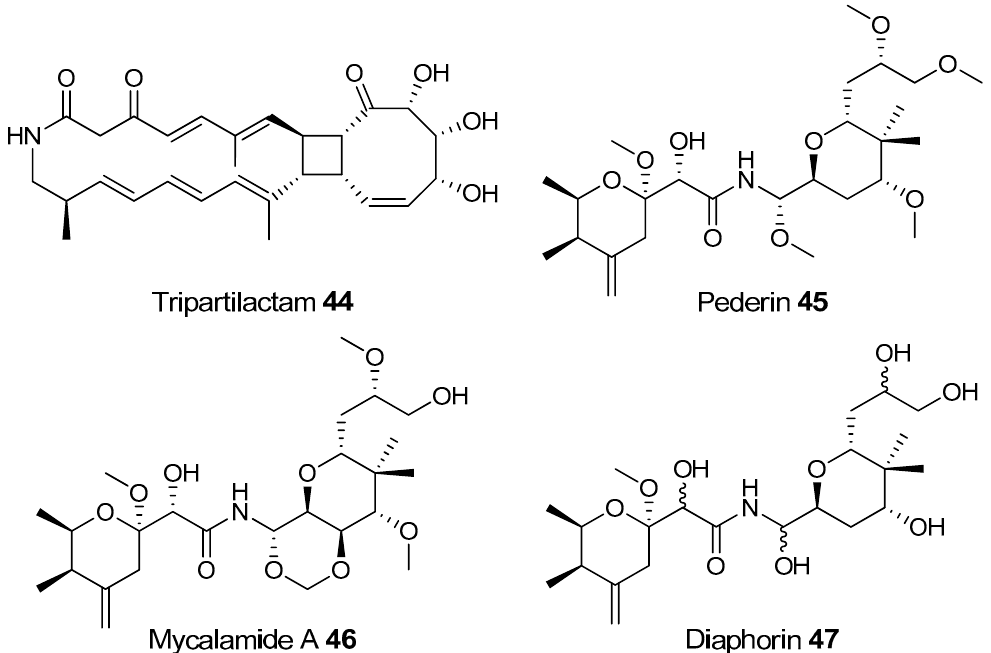
Figure 13. Tripartilactam and pederin from non-social beetles and related natural products from non-insect associated microbes.